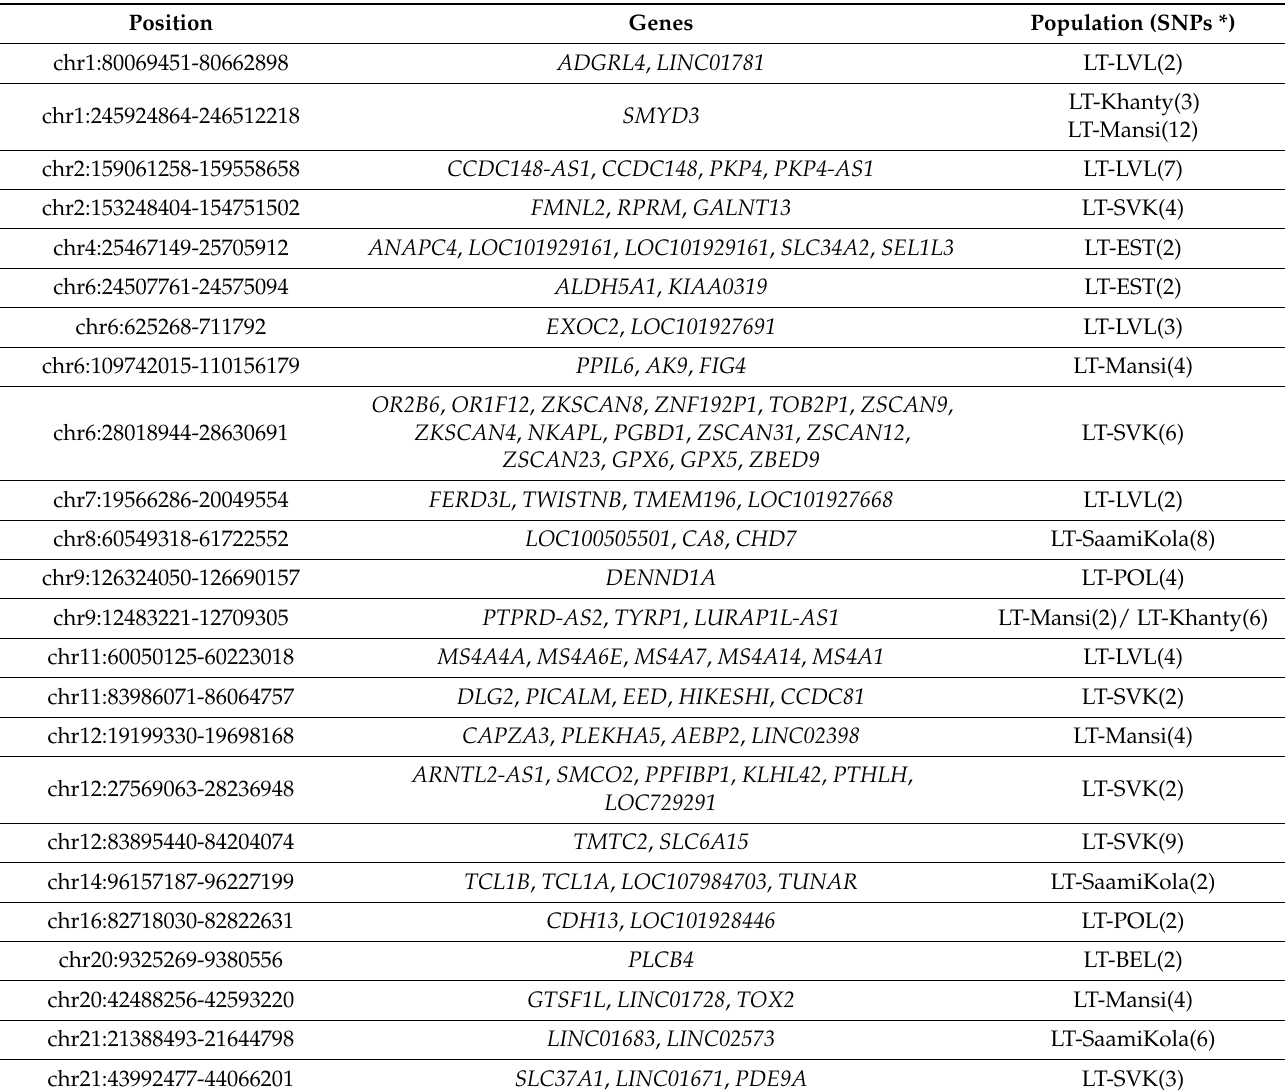
Table 1. Candidate regions for recent positive selection identified using XP-EHH and F ST .